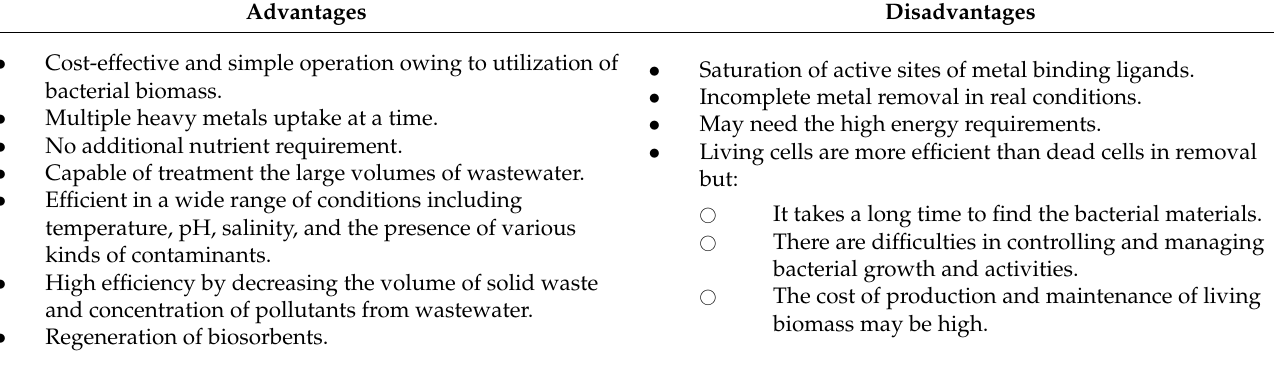
Table 5. Major advantages and disadvantages of bacterial